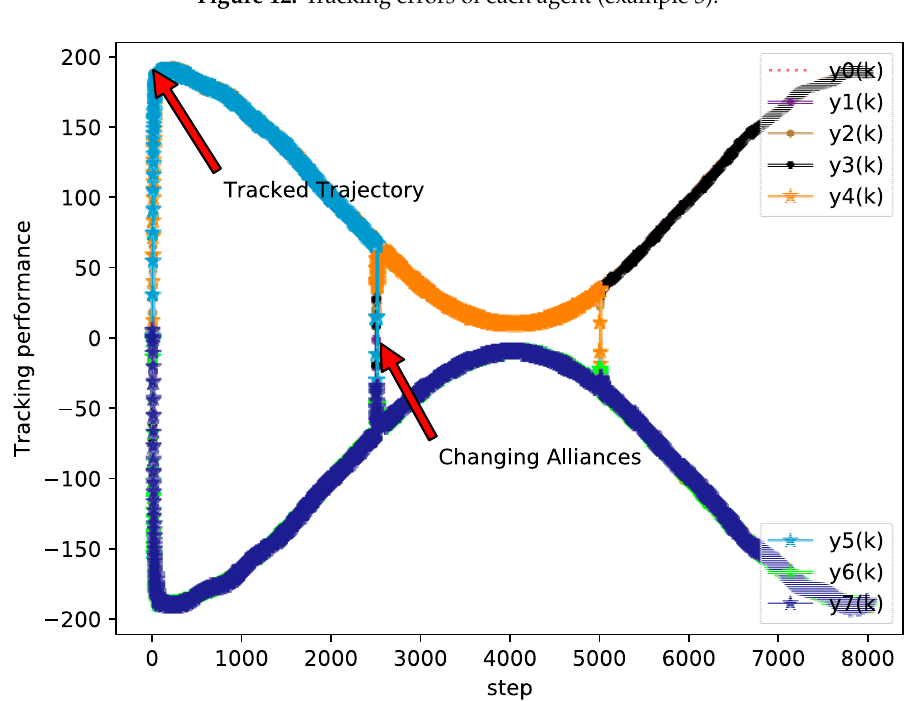
Figure 13. Tracking errors of each agent (example 4).